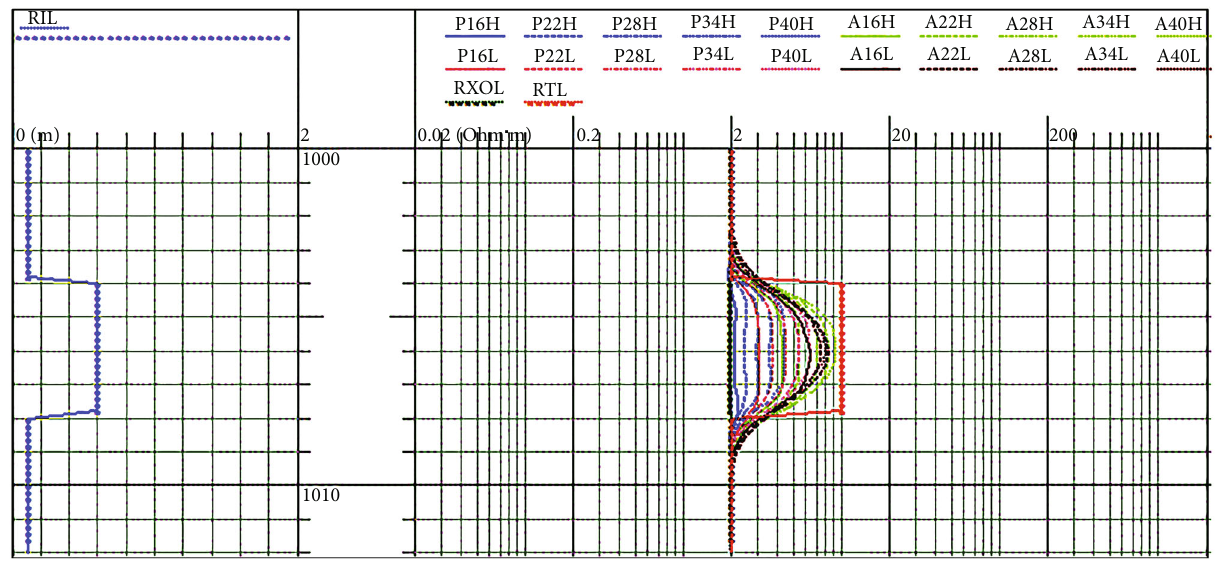
Figure 6: Inversion results.